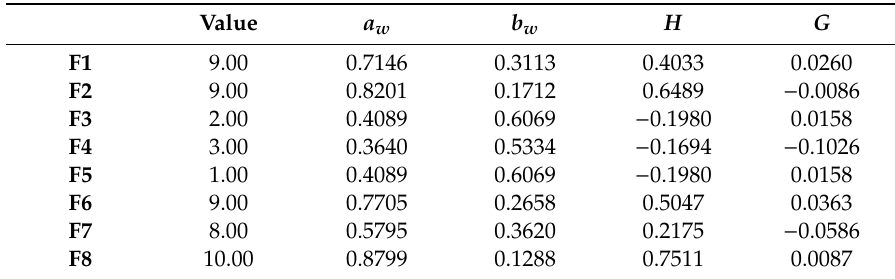
Table 13. VMEA weights